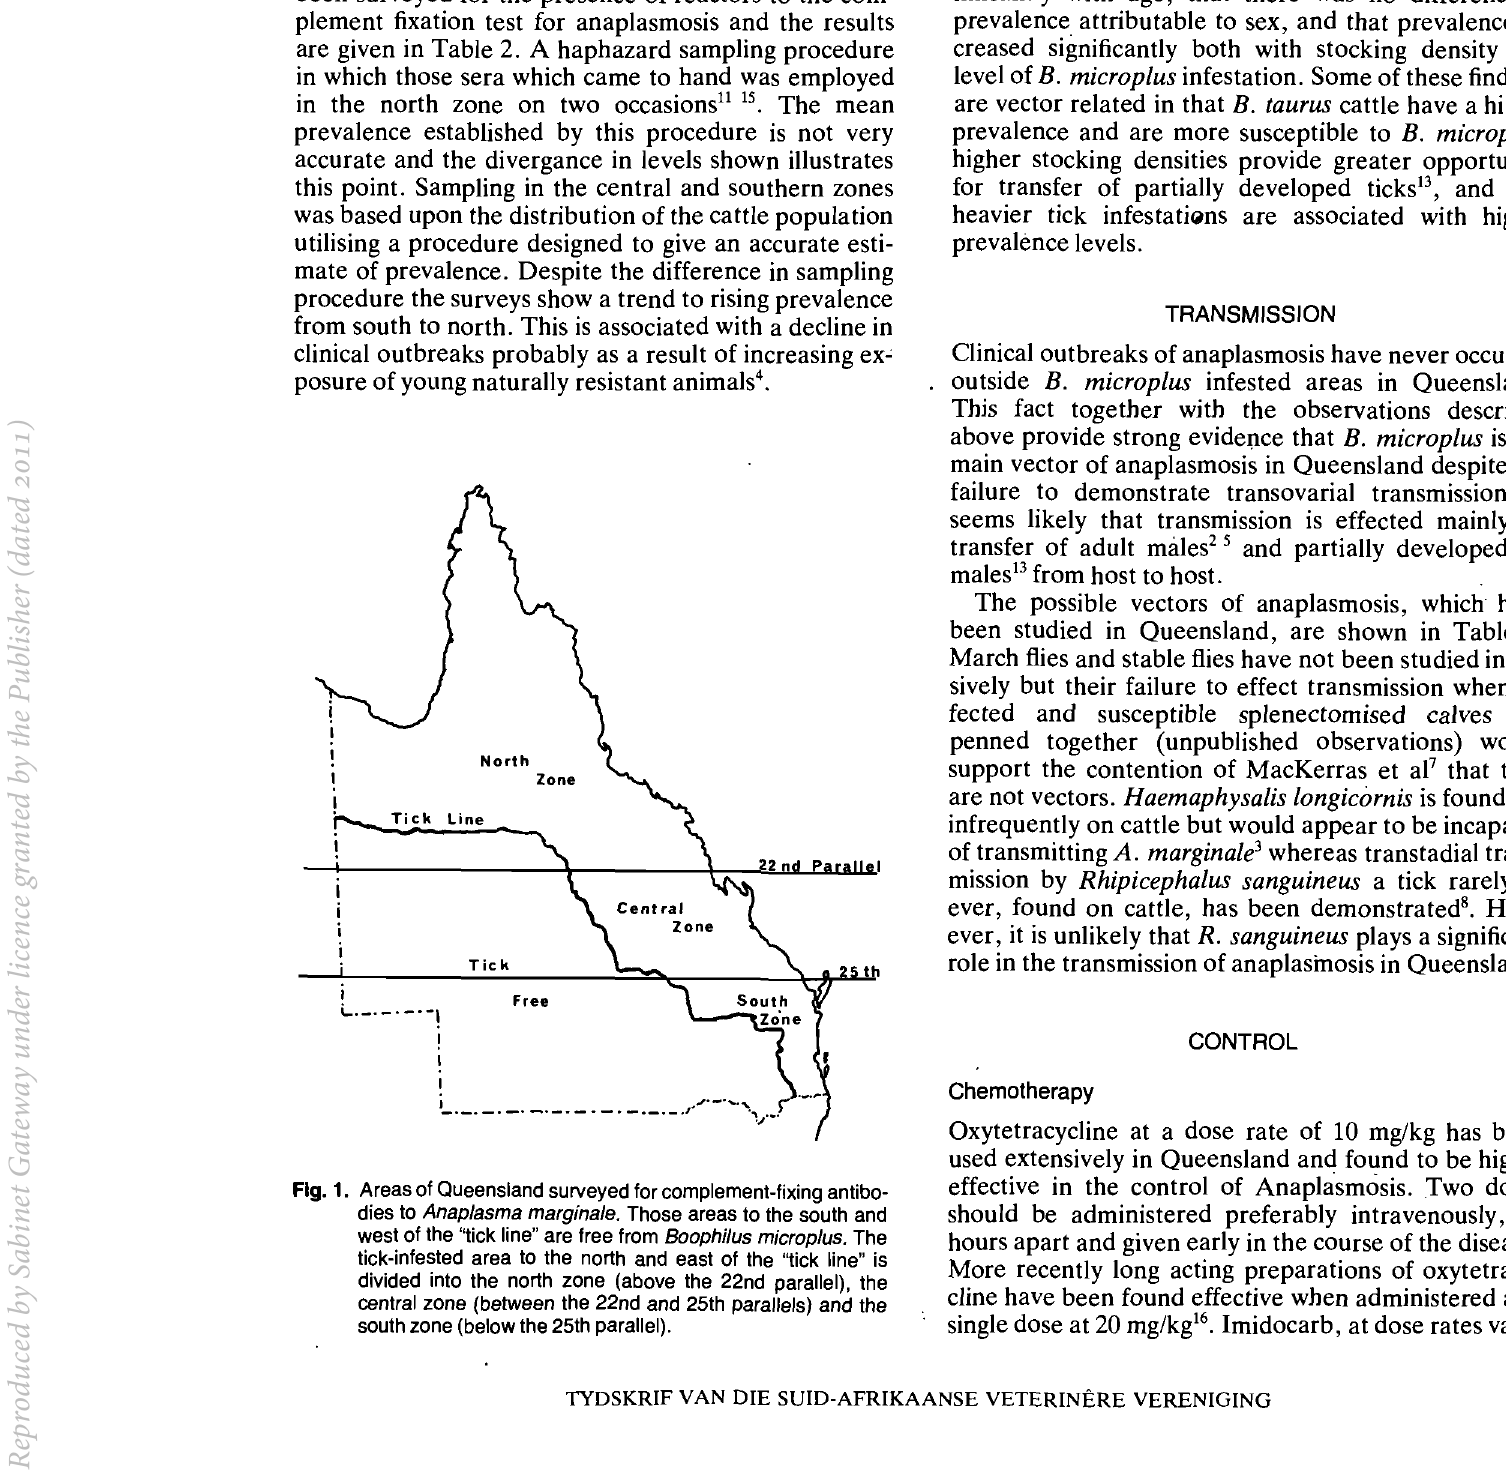
Fig. 1. Areas of QUeensland surveyed for complement-fixing antibo dies to Anaplasma marginale. Those areas to the south and west of the "tick line" are free from Boophilus microplus. The tick-infested area to the north and east of the ''tick line" is divided into the north zone (above the 22nd parallel), the central zone (between the 22nd and 25th parallels) and the south zone (below the 25th parallel).